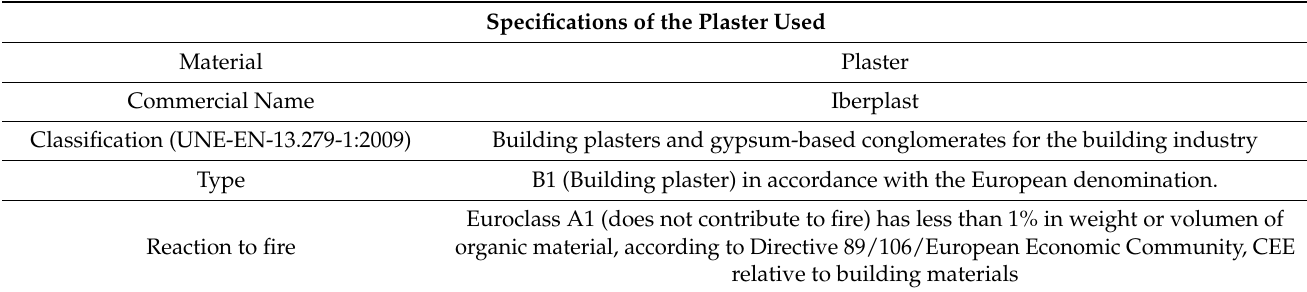
Table 1. Technical specifications of the plaster used (Source: PLACO S.A.)